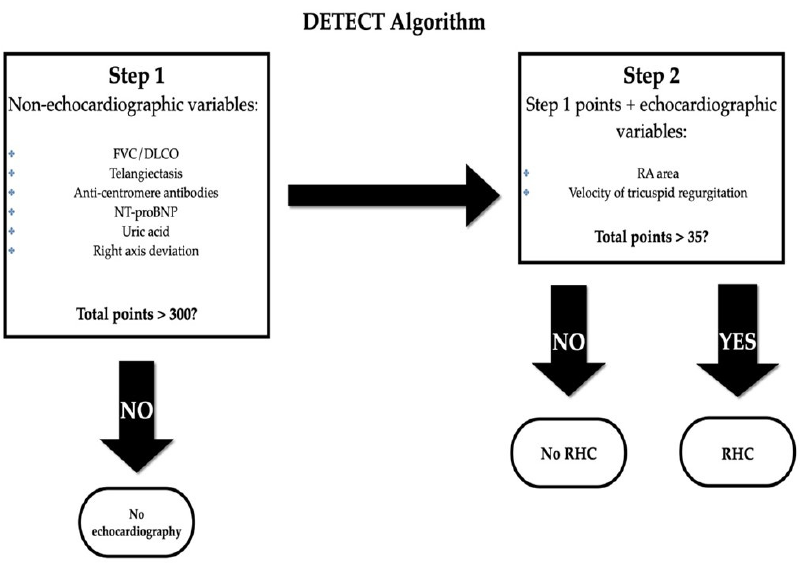
Figure 1. DETECT Algorithm. Modified after [57]. Legend: FVC forced vital capacity; DLCO diffusing capacity for carbon monoxide; NTproBNP, N-terminal pro-brain natriuretic peptide; RA, right atrium.